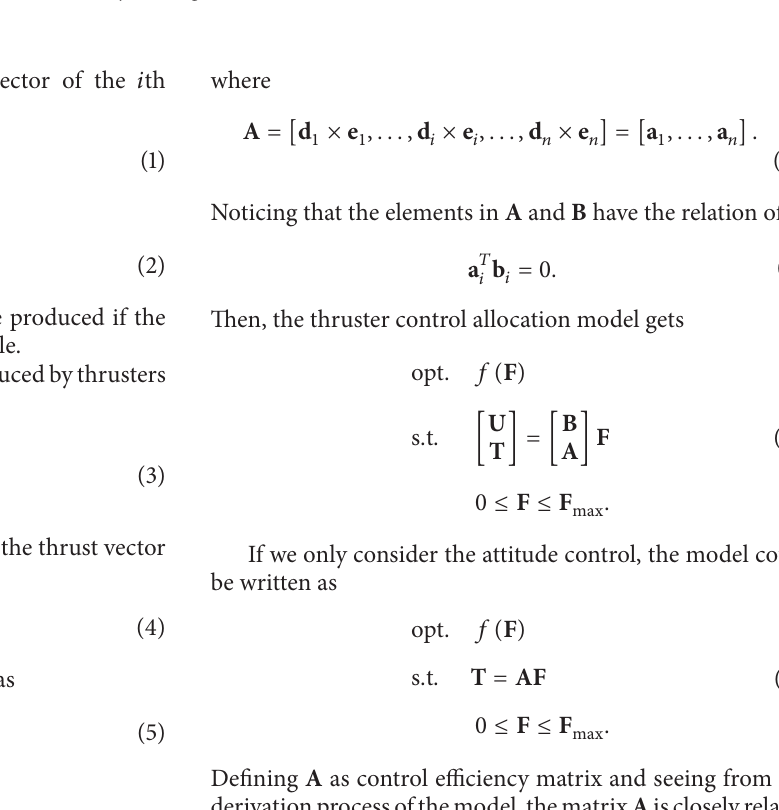
Figure 2: The layout diagram of the 𝑖 th